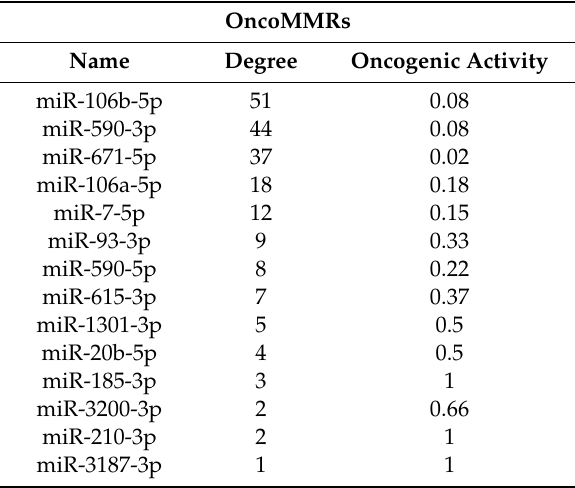
Table 2. OncoMMRs and their oncogenic